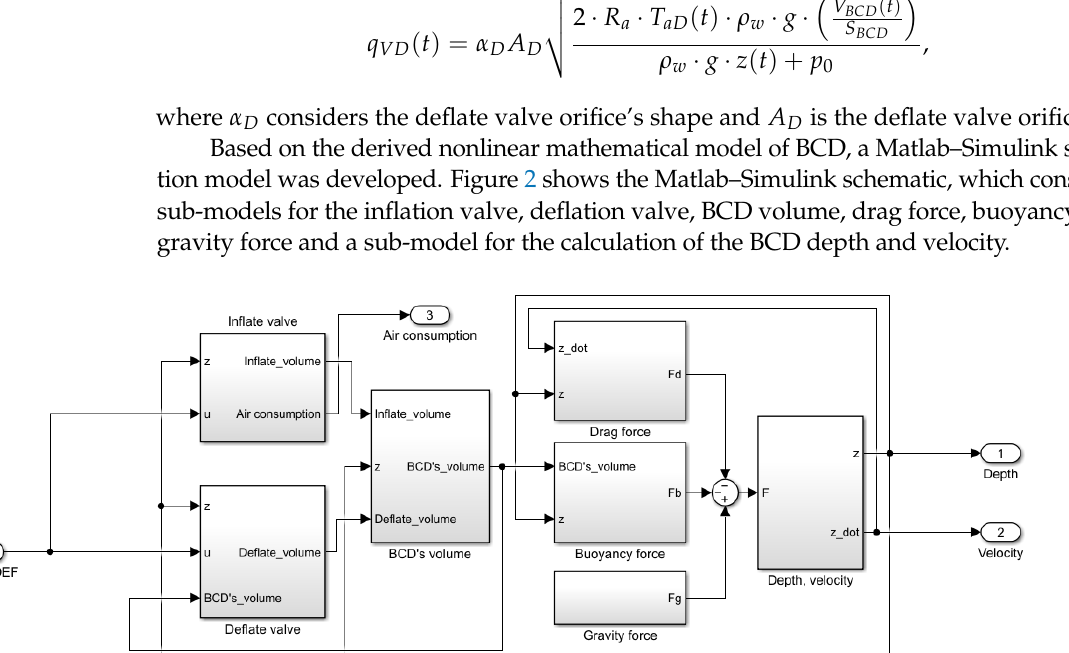
(10) and the diver’s vertical change of depth over time or ascending and descending velocity 𝑑𝑧 𝑑𝑡 ⁄ are inputs of the FLCS. The output 𝑢 of the FLCS is inflating or deflating action of the electro ‐ pneumatic BCD valves. Figure 3. Fuzzy PD logic controller setup.